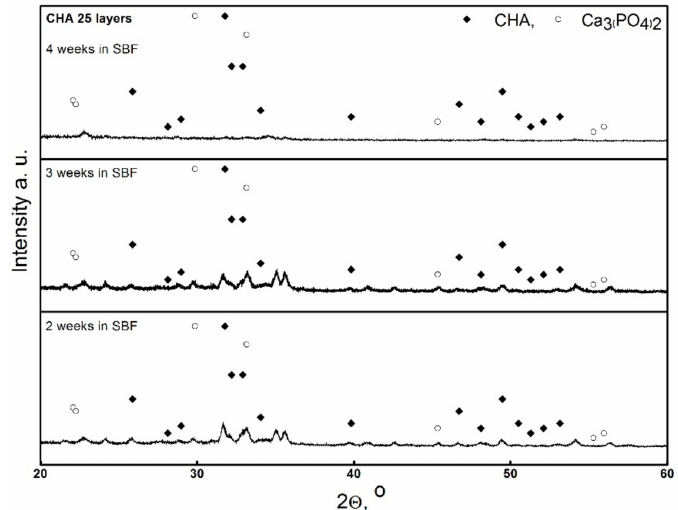
Figure 12. XRD patterns of CHA samples coated with 25 layers after immersion in SBF for 2, 3, and 4 weeks.